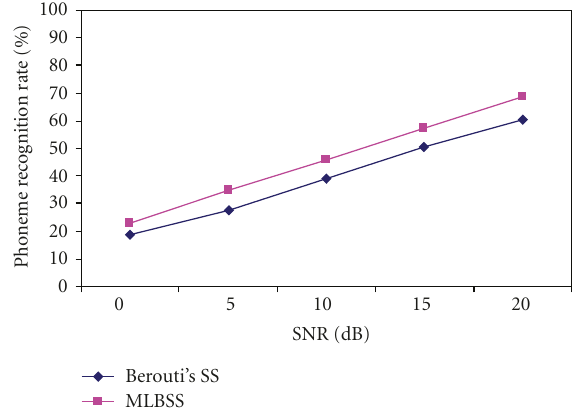
Figure 4: Phoneme recognition accuracy rate (%) as function of SNR with Berouti et al.’s speech enhancement approach and single- band MLBSS